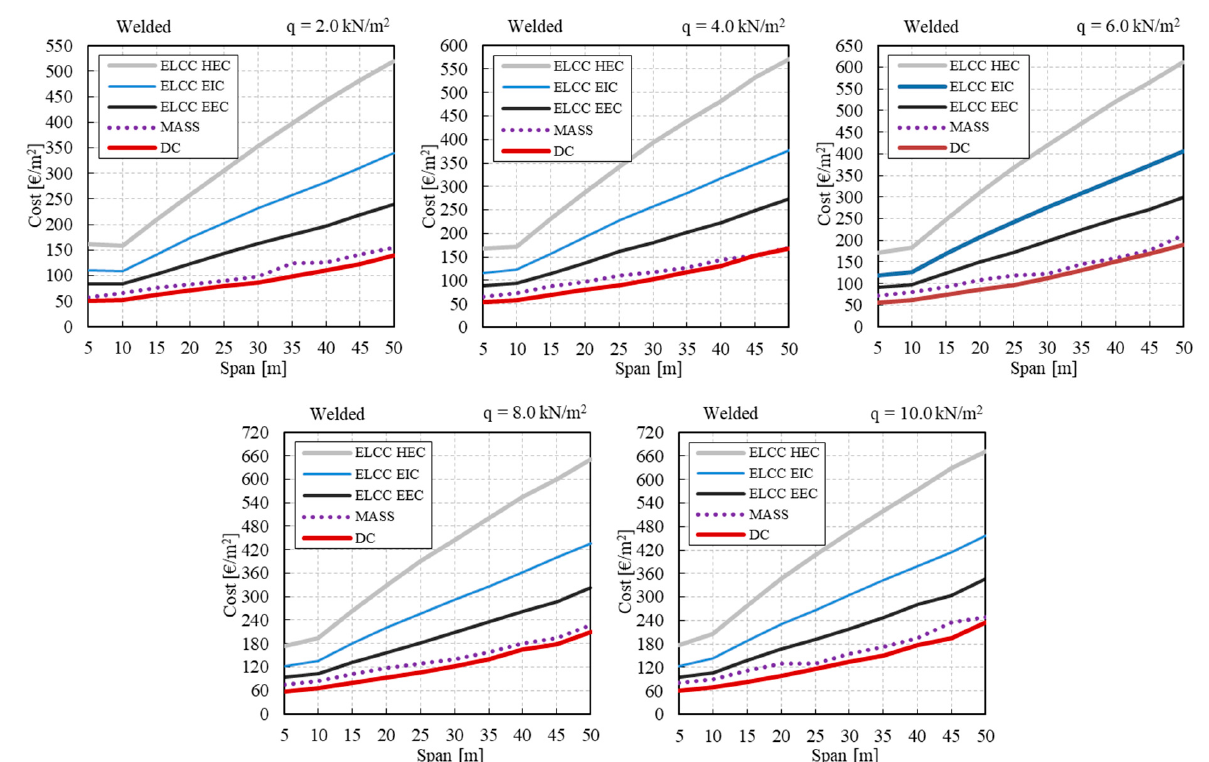
Figure 10. Diagrams of the calculated costs of the CFSWIS structures for different objective functions.